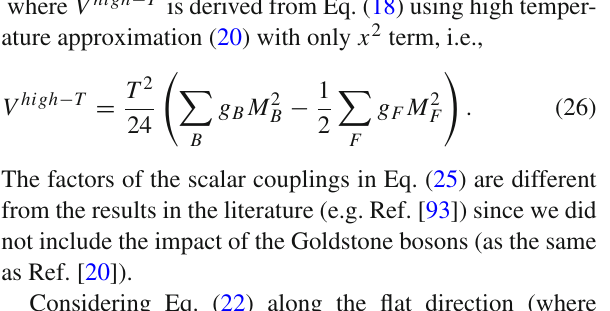
Fig. 3 Thermal functions and their different approximations